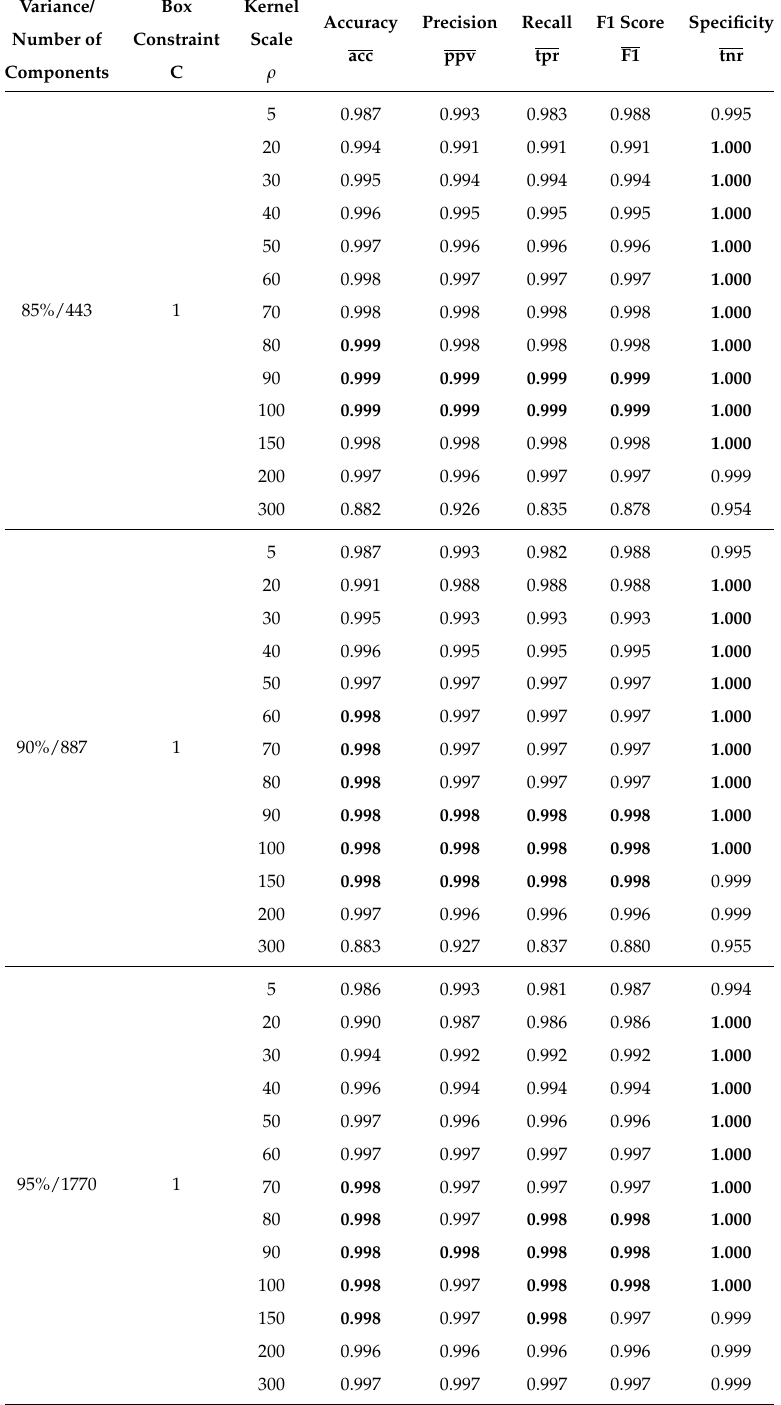
Table 8. Evaluation indicators for the SVM model using different percentages of variance and different values for ρ (kernel scale). The best values for each indicator are highlighted using a boldface